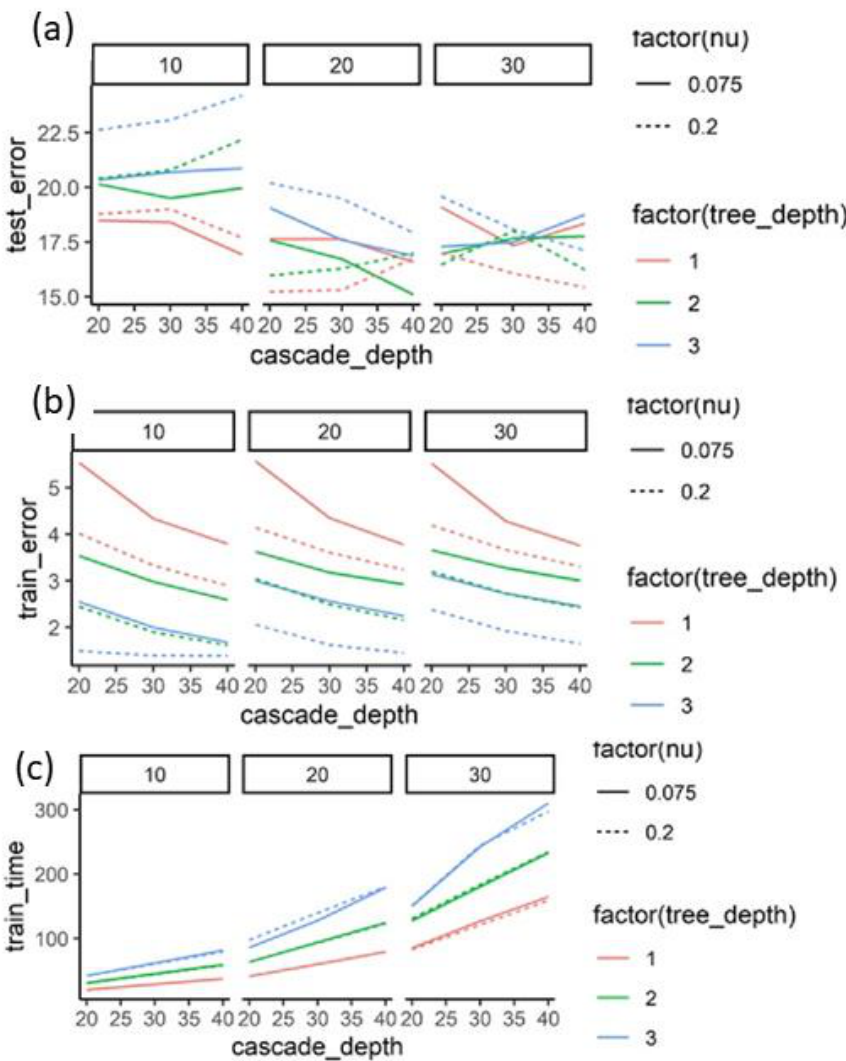
Figure 3. Effects of learning parameters on performance. ( a ) Mean distance between the predicted and labeled landmarks in pixels plotted on the y axis for the test images. ( b ) Mean distance between the predicted and labeled landmarks in pixels plotted on the y axis for the train images. ( c ) Training time in seconds for prediction models trained with different learning parameters .